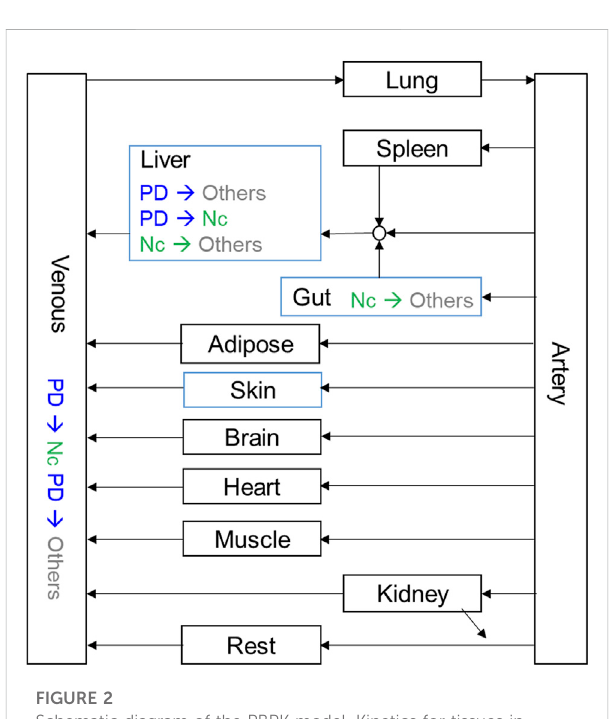
FIGURE 2 Schematic diagram of the PBPK model. Kinetics for tissues in black boxes were set as perfusion-limited, and kinetics for tissues in blue boxes were set as